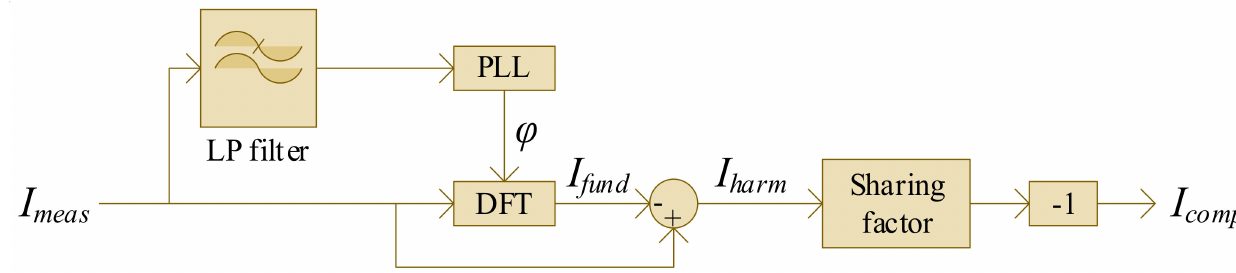
Figure 26. Harmonics filtering function.